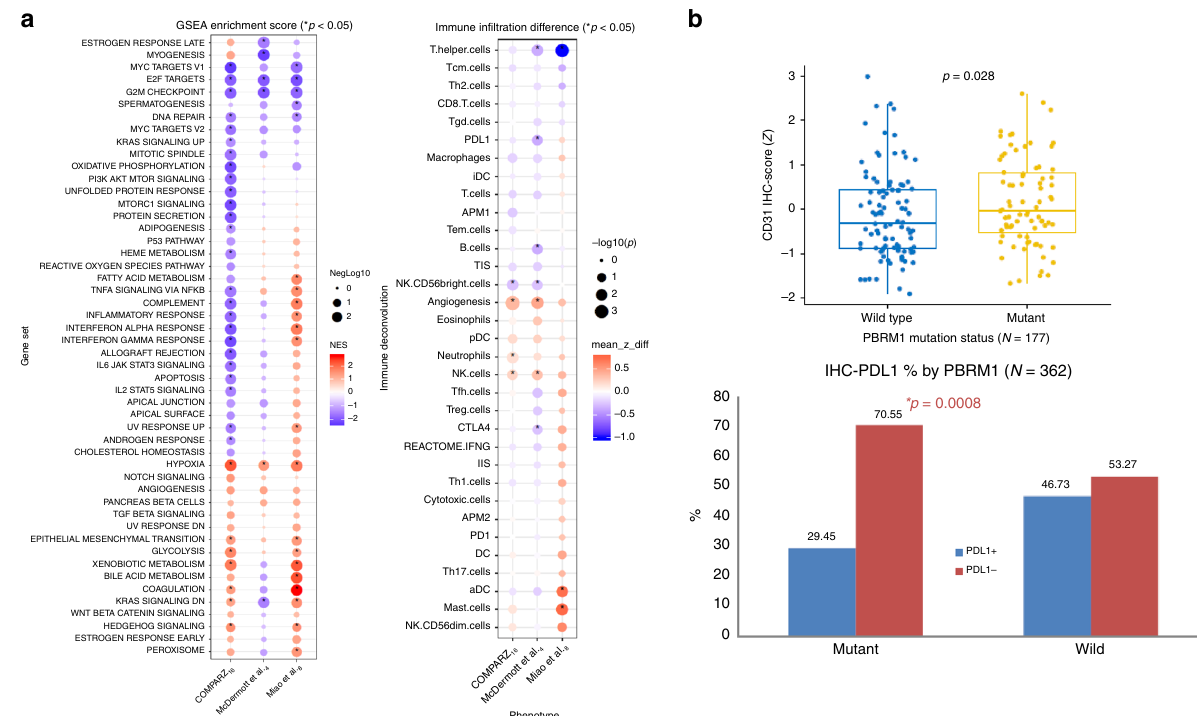
Fig. 7 Immune deconvolution of PBRM1 mutated tumors. a Immune deconvolution using single sample gene set enrichment analysis (GSEA), focusing on immune and angiogenic gene signatures. Signi fi cantly higher angiogenic gene expression was observed in PBRM1 mutated tumors in the COMPARZ 16 and McDermott et al. 4 data sets, p = 0.0004 and 0.005, respectively, and a similar trend in the Miao et al. 8 cohort. b Immunohistochemistry staining results from COMPARZ 16 and McDermott et al. 4 data sets demonstrate signi fi cantly higher CD31 + staining in PBRM1 mutated tumors and lower PD-L1 + staining in PBRM1 mutated tumors. Box plot: middle line of box indicates median and the bounds indicate quartile 1 and quartile 3. The whiskers reach to the maximum/minimum point within the 1.5 × interquartile range from quartile 3/quartile 1, respectively. P values from COMPARZ 16 bar plots generated by Fisher ’ s exact test; p values from the GSEA plot derived from a permutation test; p values from immune deconvolution difference plot and box plots derived from Wilcoxon rank-sum test. The Fisher ’ s Exact test and Wilcoxon rank-sum test p values are two sided. No adjustments made for multiple comparisons; all p values are